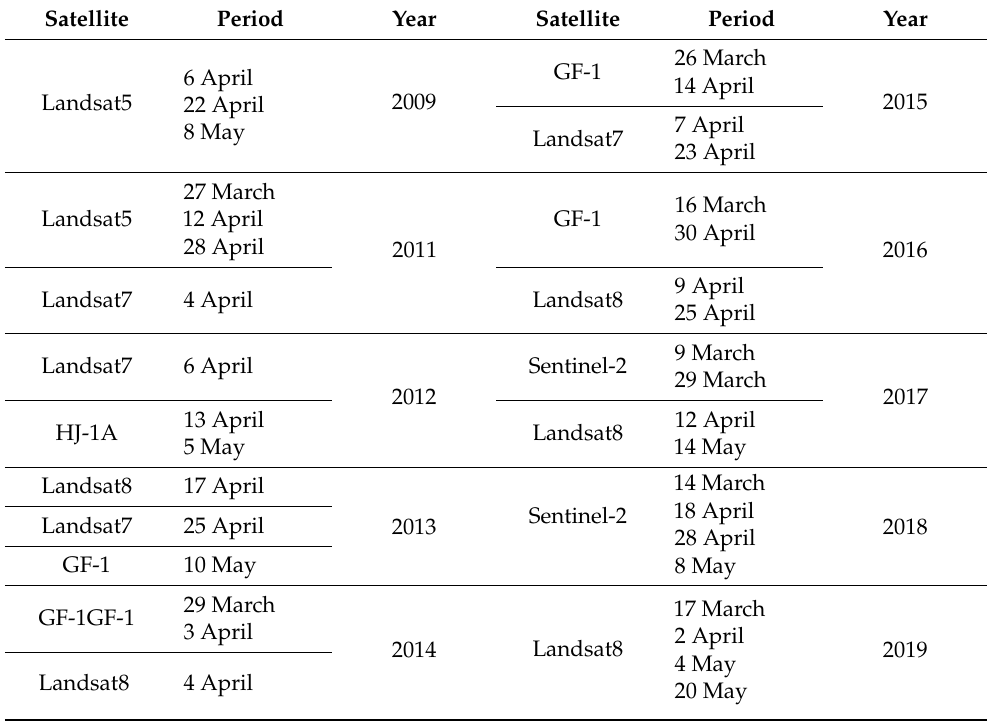
Table 1. Acquisition dates of the RS images.